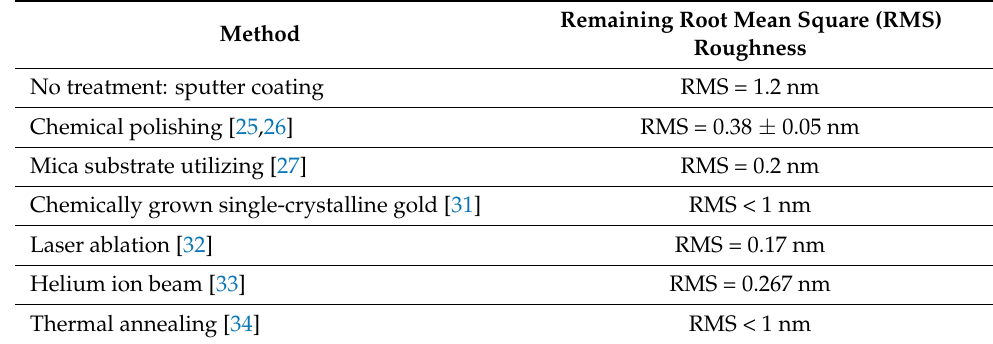
Table 1. Shows surface roughness and surface smoothing